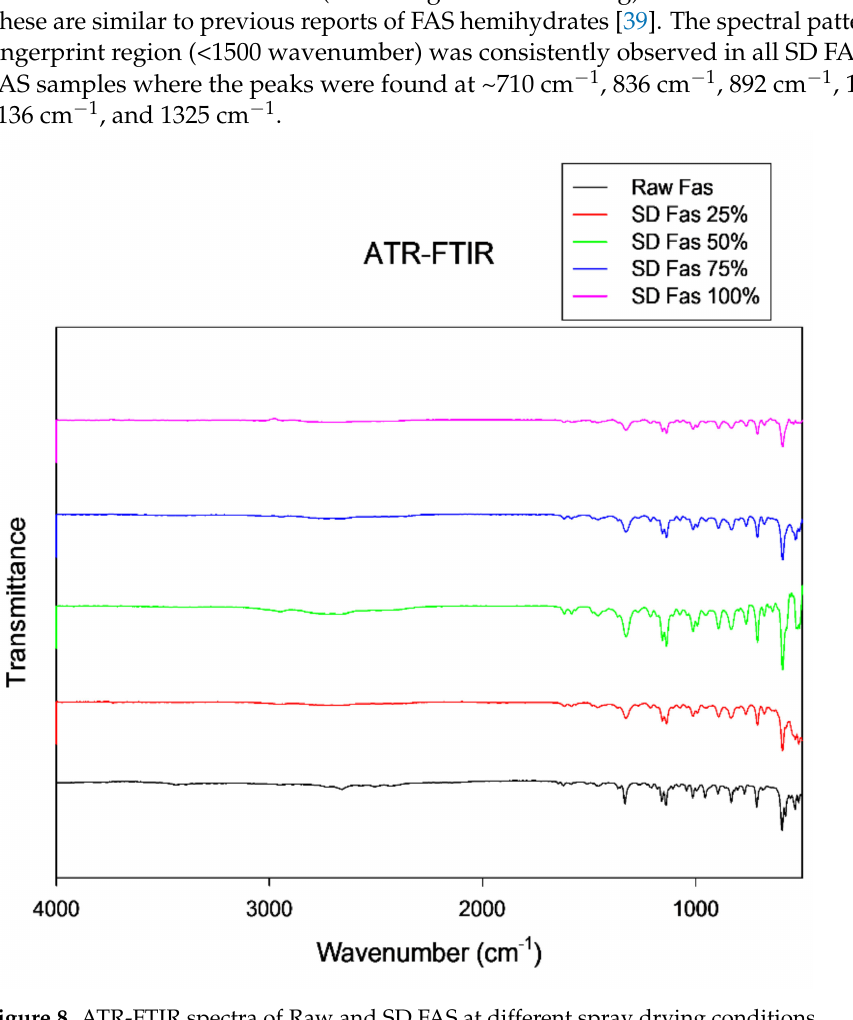
Figure 8. ATR-FTIR spectra of Raw and SD FAS at different spray drying